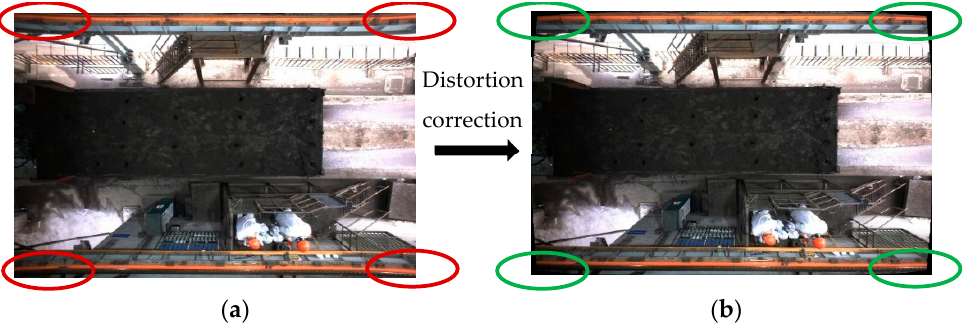
Figure 8. Comparison of before and after distortion correction. ( a ) Before distortion correction. ( b ) After distortion correction.